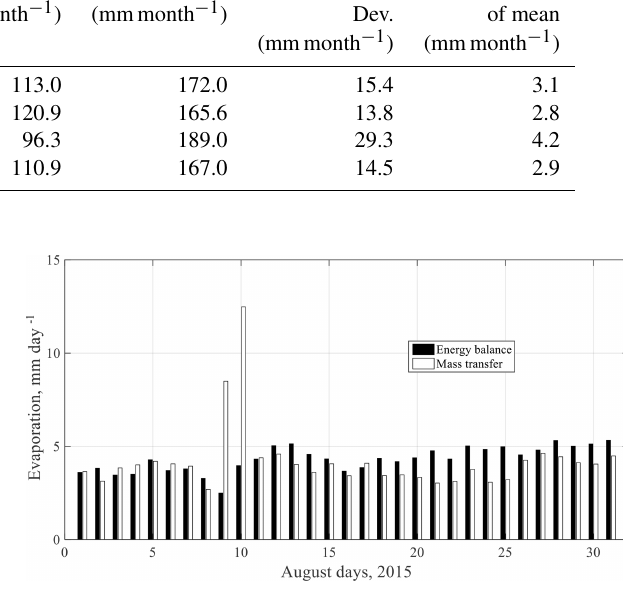
Figure 10. Daily evaporation computed by the mass transfer (shaded staples) and energy balance (filled staples)